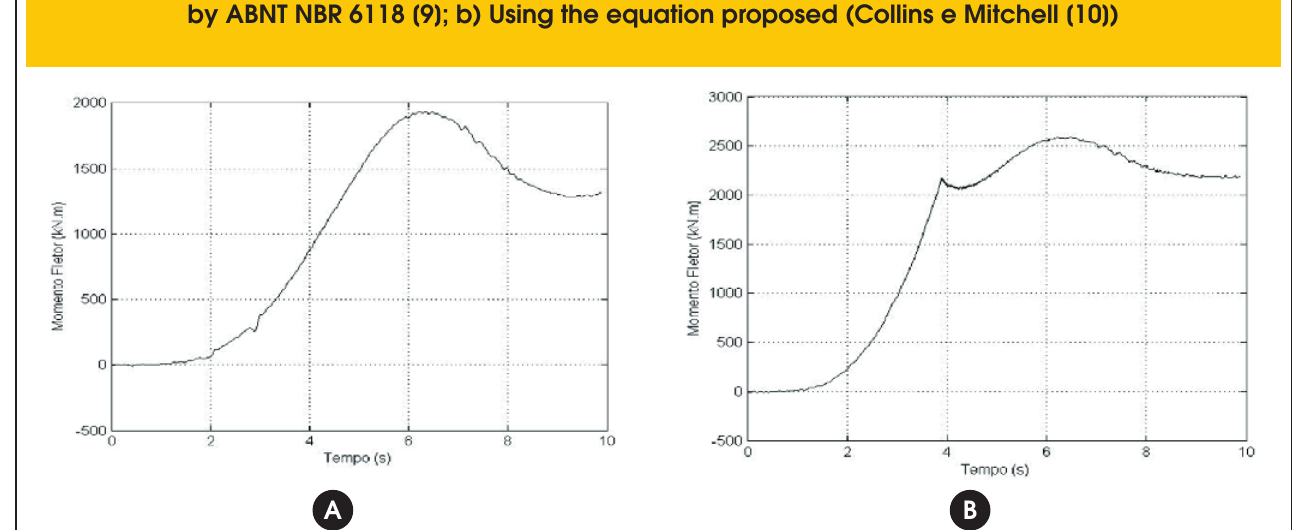
Figure 20 – Bending moments' time-series at midspan. a) Using the equation